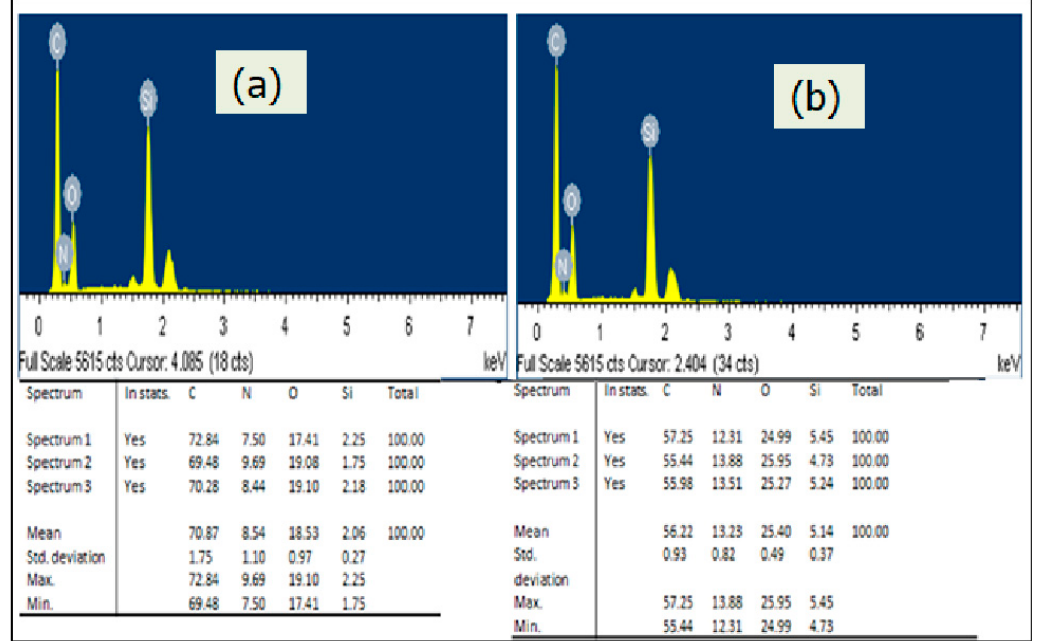
Figure 9. EDX spectra and weight percentages of identified elements ( a ) COF-S7 and ( b ) COF-S12.